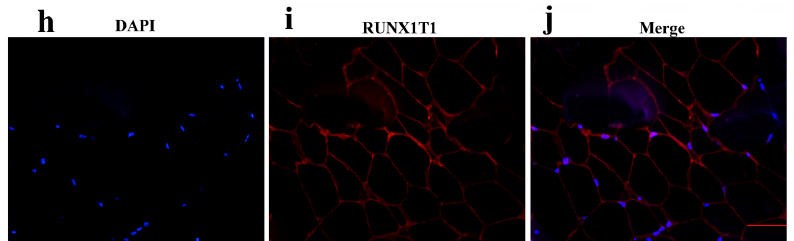
Figure 5. Expression patterns of RUNX1T1 isoforms in the subcutaneous fat. The temporal expression of RUNX1T1 isoforms ( a – c ) and FTO mRNA ( d ) and RUNX1T1 protein ( e ) in the subcutaneous fat of Hu sheep at different ages were measured using Real-time PCR and Western blot (5 d, 3 M, 6 M and 24 M). d means day, M means month. Semi-quantitative analysis of the relative RUNX1T1 protein expression levels in the subcutaneous fat at different developmental stages was undertaken ( f ). Real-time PCR was performed on different developmental stages of subcutaneous fat to determine the expression level of marker genes ( g ), and immunofluorescence localization of RUNX1T1 in the subcutaneous fat of 24-month-old Hu sheep ( h – j ). Blue color indicates 4 (cid:48) ,6-diamidino-2-phenylindole (DAPI) staining of the nuclei ( h ). Red color indicates the expression of RUNX1T1 ( i ). Pictures in ( g ) and ( h ) were merged ( j ). Scale bars = 100 µ m. One-way ANOVA, and bars with different letters are significantly different ( p < 0.05). Quantitative data are shown as mean ± SEM ( n = 5).